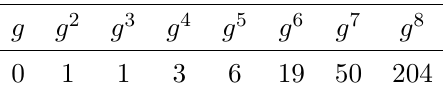
Table 2 . Number of topologically distinct 1PI 0-pt diagrams without